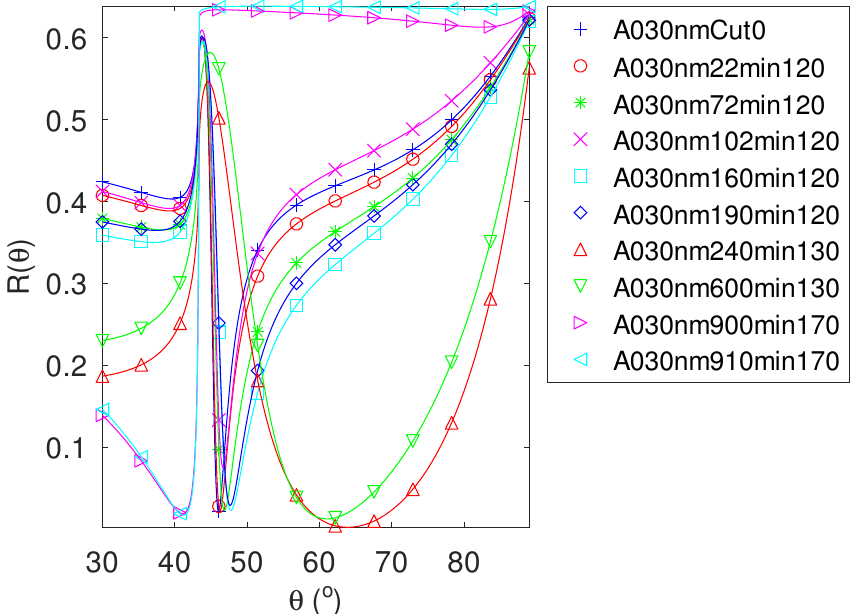
Figure 3. Simulated SPR setup signal for the samples of initial target thickness 30 nm. The calculation uses the parameters deduced from the fitting of UV-visible-NIR absorbance curves, at wavelength λ 0 = 632.8 nm. Upper medium is